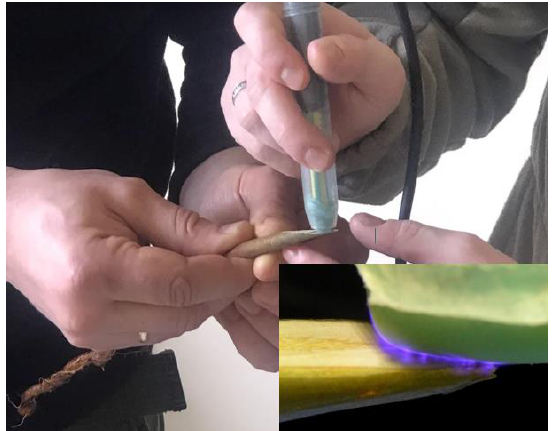
Figure 6. Processing (DBD CAP) a cut of a sweet cherry rootstock. The dielectric working surface of the replaceable module interacts with the cut surface and performs a sliding circular motion.